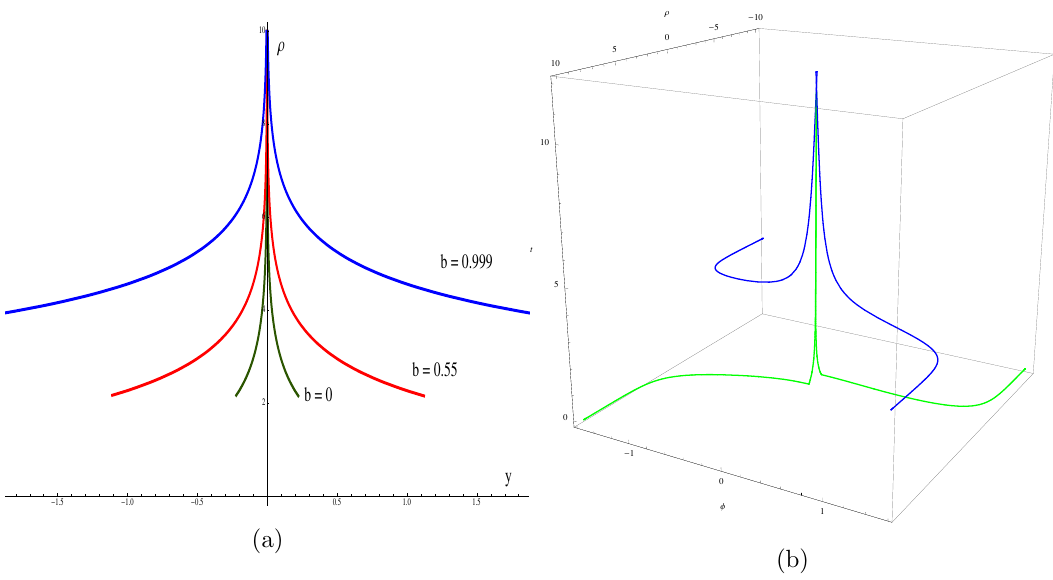
Figure 2. Plot of ‘Spiky’ strings, (a) Strings in the (cid:26) (cid:0) y plane with ! = 0 : 55 and v = 0 : 45. Notice that with increasing b , the spikes become wider, which we refer to as ‘fattening’ of the spike. (b) A 3 d view of the fattening of spike in ( t; (cid:26); (cid:30) ) space for b = 0 (green) and b = 0 : 2 (blue). The snapshot is taken at (cid:28) =